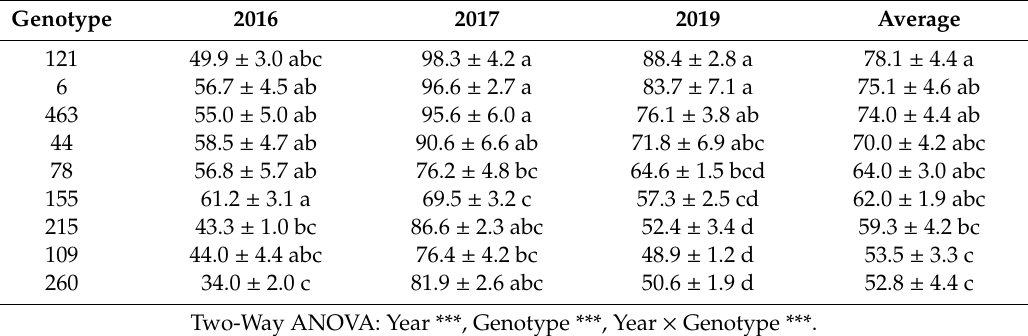
Table 4. Variation in WUE i ( µ mol CO 2 mol − 1 H 2 O) per genotype and year in Roda field (values are means ± SE).